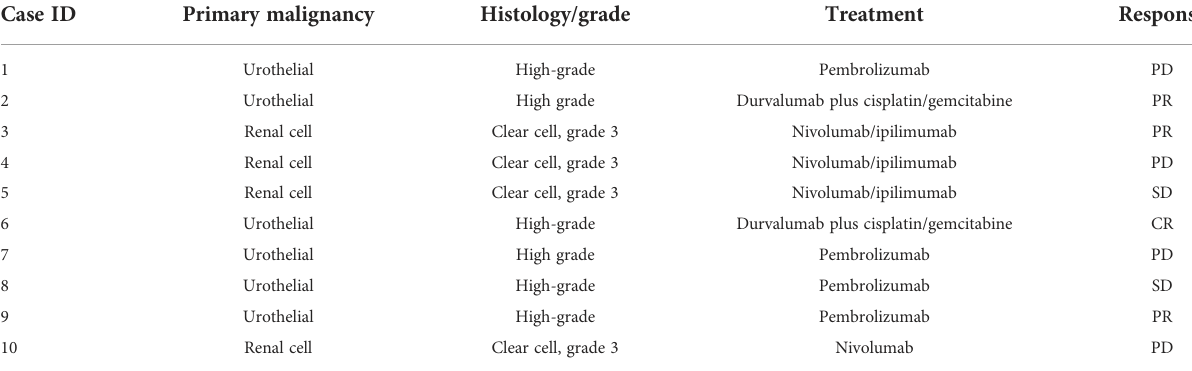
TABLE 1 Baseline characteristics and response to checkpoint